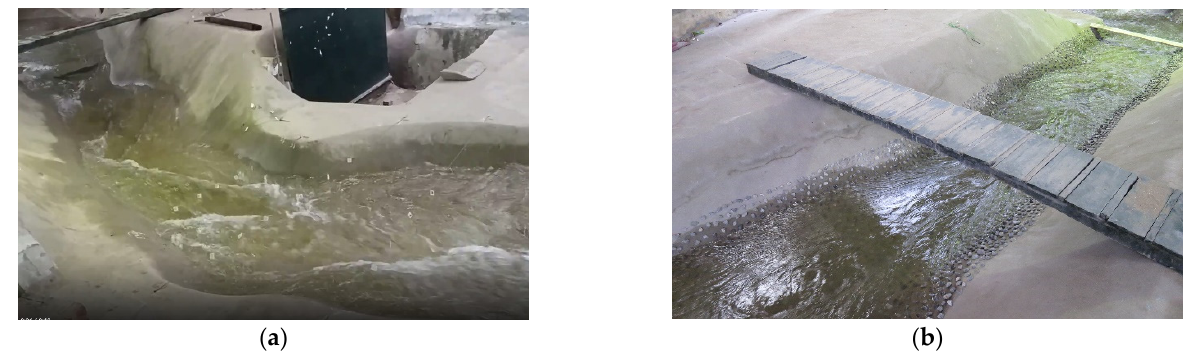
Figure 9. River section modeling in ( a ) baseline experiment, ( b ) attached grain